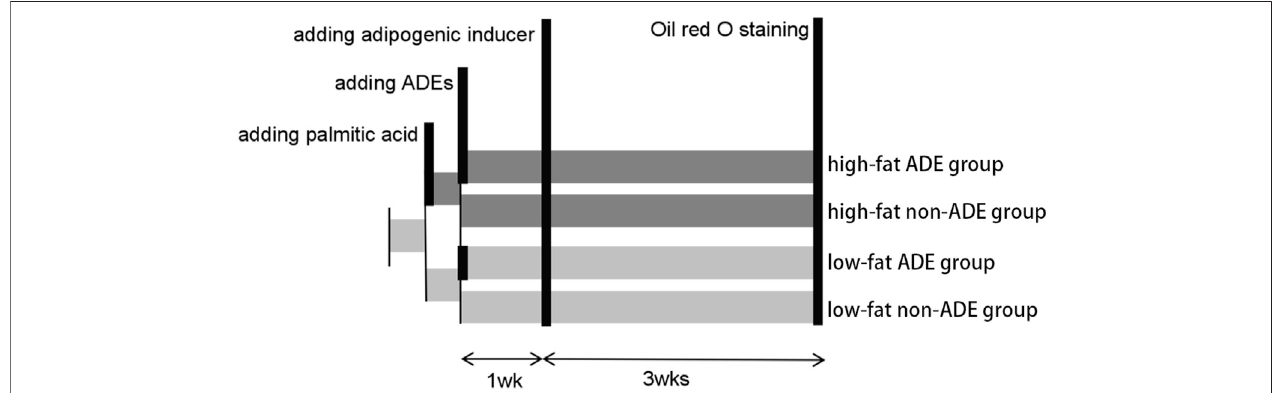
FIGURE 1 | Schematic of the experimental design. ADSCs were cultured in an exosome-free medium. In the high-fat exposure group, 50 μ M palmitic acid dissolved in bovine serum albumin was added to ADSCs to create a high-fat environment. ADSCs were co-cultured with ADEs in the ADE group. After 1 week, an adipogenic inducer was added to the media.